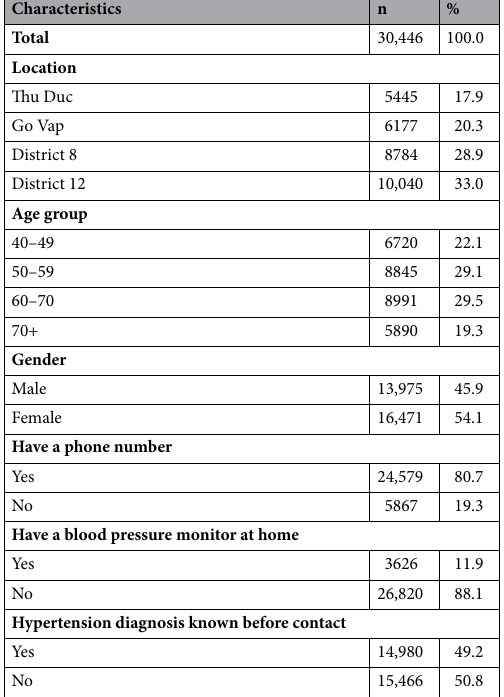
Table 3. Profiles of clients registered in the